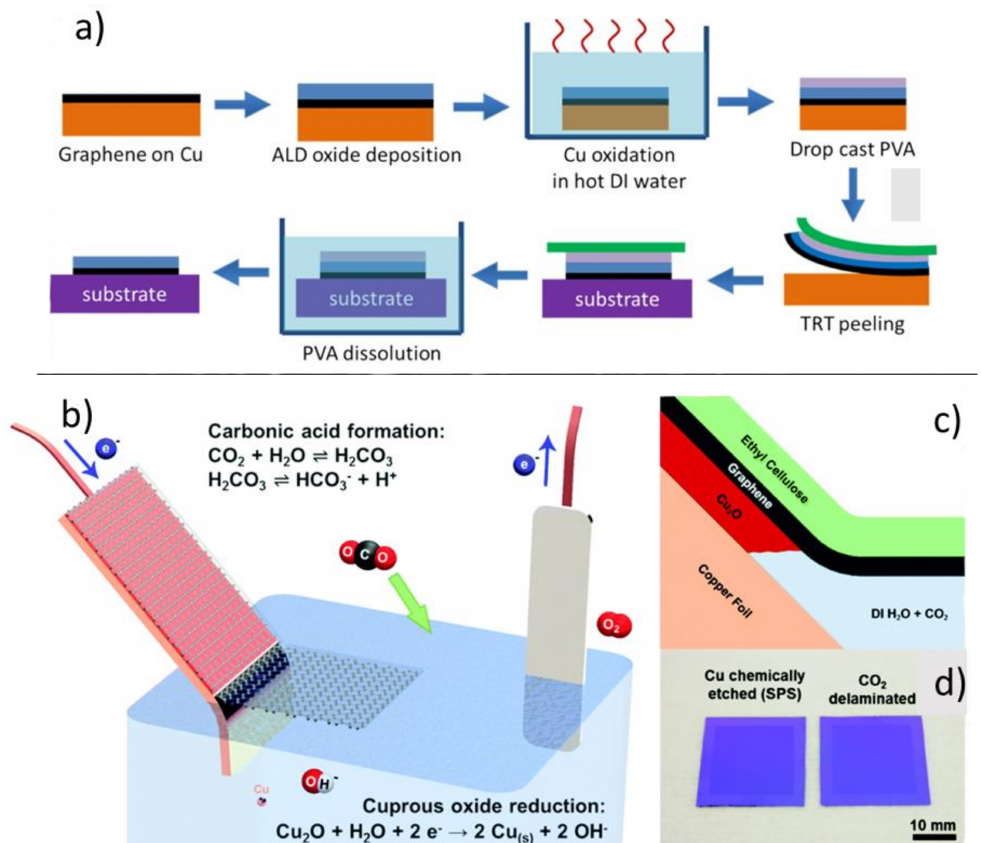
Figure 5. ( a ) Copper oxidation − assisted graphene delamination using ALD aluminum oxide to promote graphene peeling. Adapted under the terms of the Creative Commons Attribution 3.0 license from Ref. [58]. Copyright 2017 IOP Publishing Ltd. ( b ) Electrode setup for electrolytic removal of copper oxide passivating layer between graphene and the copper growth substrate. ( c ) Illustration of hypothesized chemical process for copper oxide dissolution. ( d ) Comparison of graphene transferred onto SiO x using chemical etching of copper vs. non-etching substrate removal. ( b – d ) Adapted with permission from Ref. [61]. Copyright 2017 Royal Society of